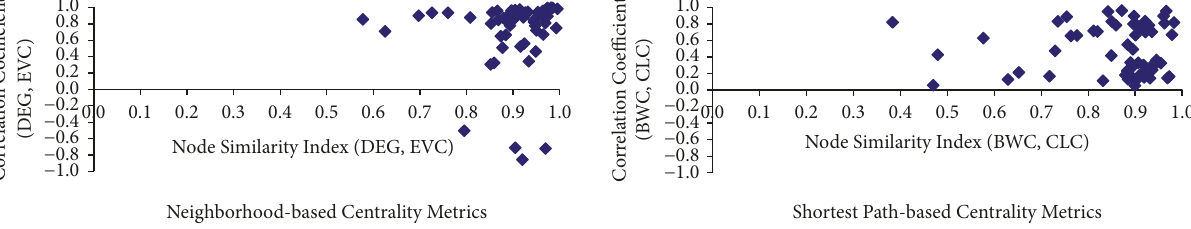
Figure 6: NSI values versus Pearson's correlation coefficient values for the centrality